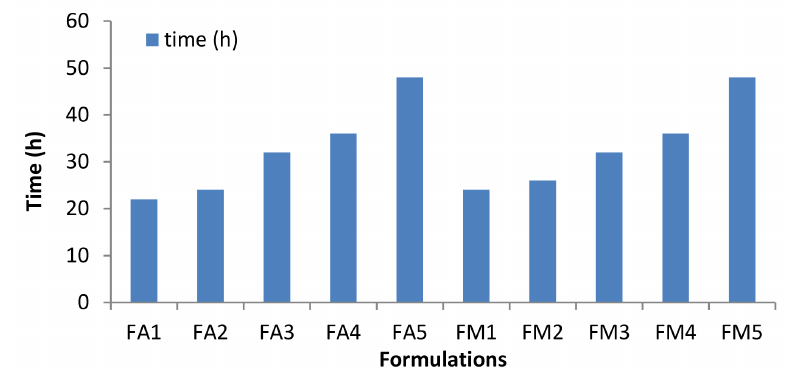
FIGURE 4 - In-vitro Mucoadhesion Study by Rotating Cylinder